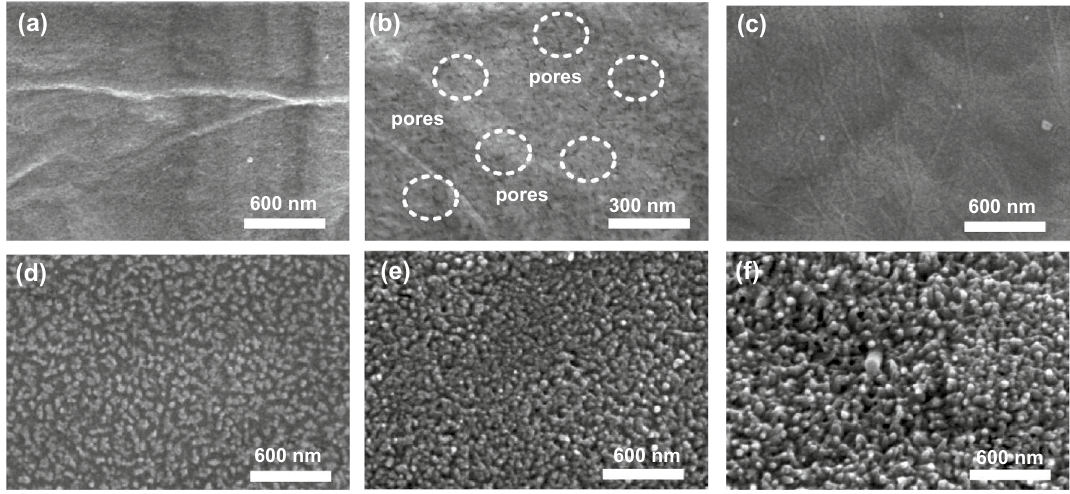
Fig. 2 a , b Scanning electron microscopy (SEM) images of porous RGO/PEDOT framework at different scales, c – f SEM of hierarchical and porous RGO/PEDOT/PANI hybrid with different electrodeposition durations of PANI: 5, 10, 15, and 20